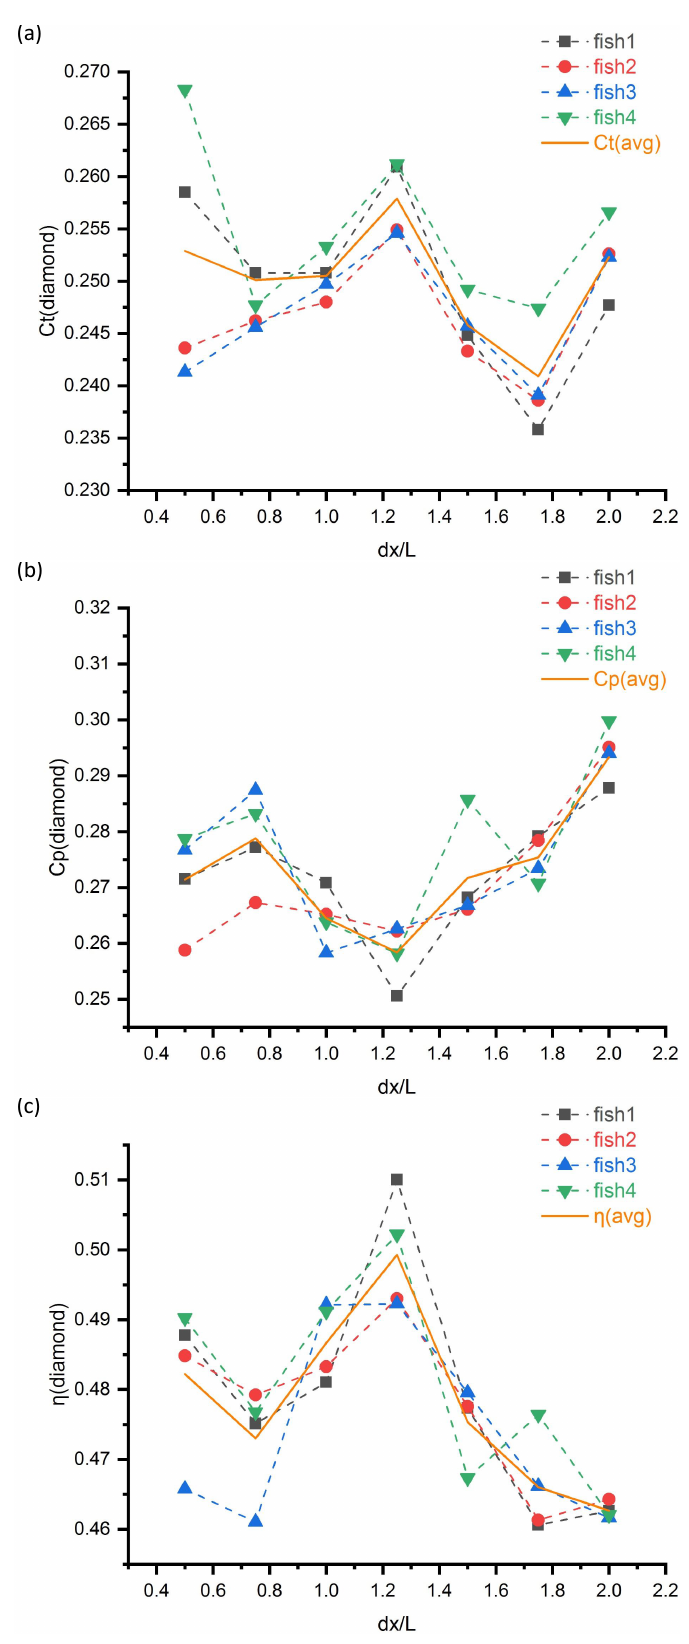
Figure 15. Results of the diamond swarm: ( a ) non-dimensional thrust coefficients C t , ( b ) non-dimensional lateral power loss coefficients C p , ( c ) the Froude efficiency η